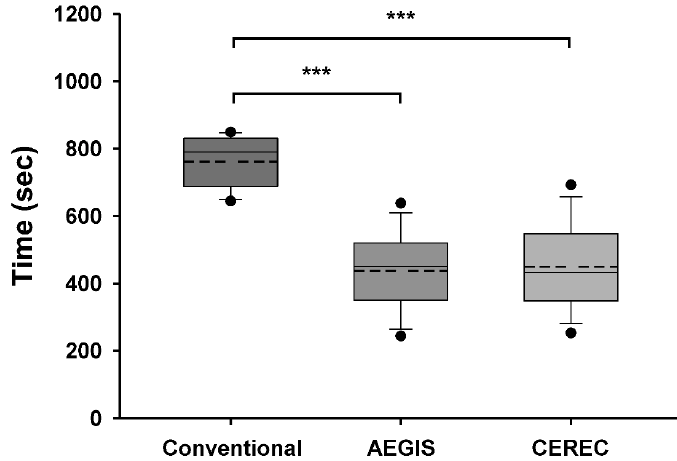
Figure 8. Box plot of the time required for each impression method (***, p < 0.001).